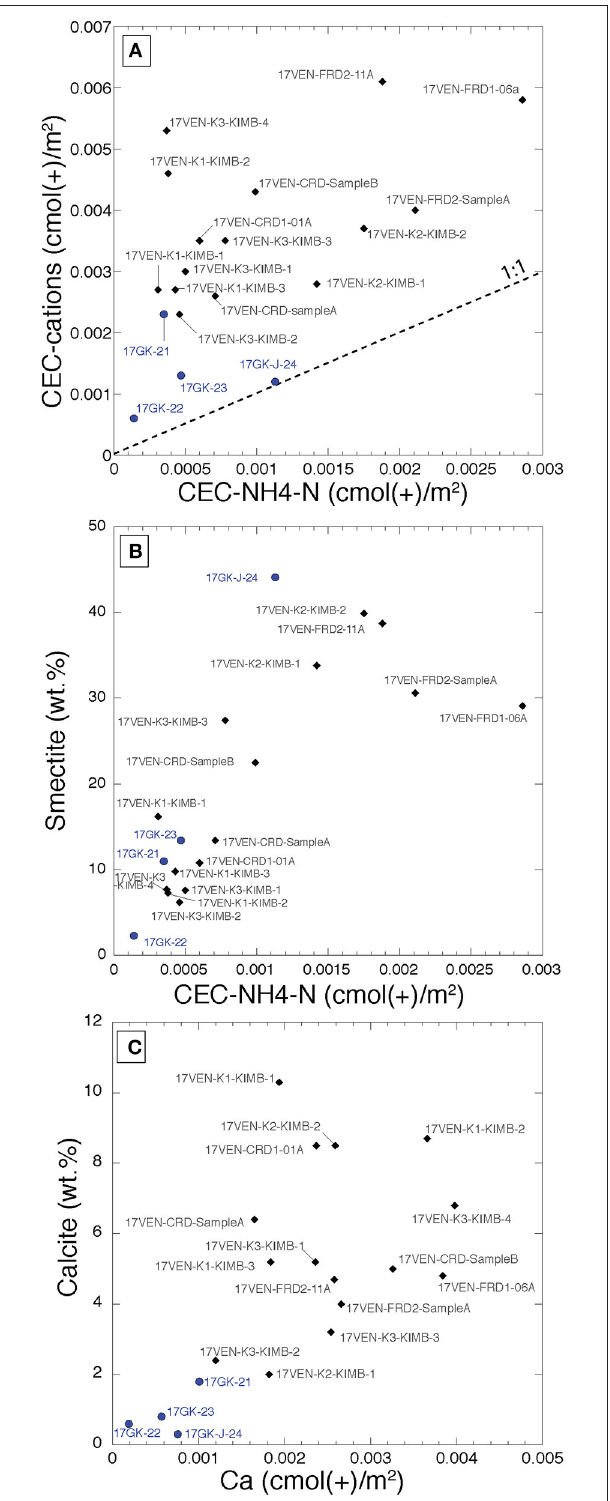
FIGURE 4 | Biplots representing (A) the CEC determined by the NH 4 -N concentrations in the KCl leachates (CEC-NH 4 -N) vs. the CEC determined